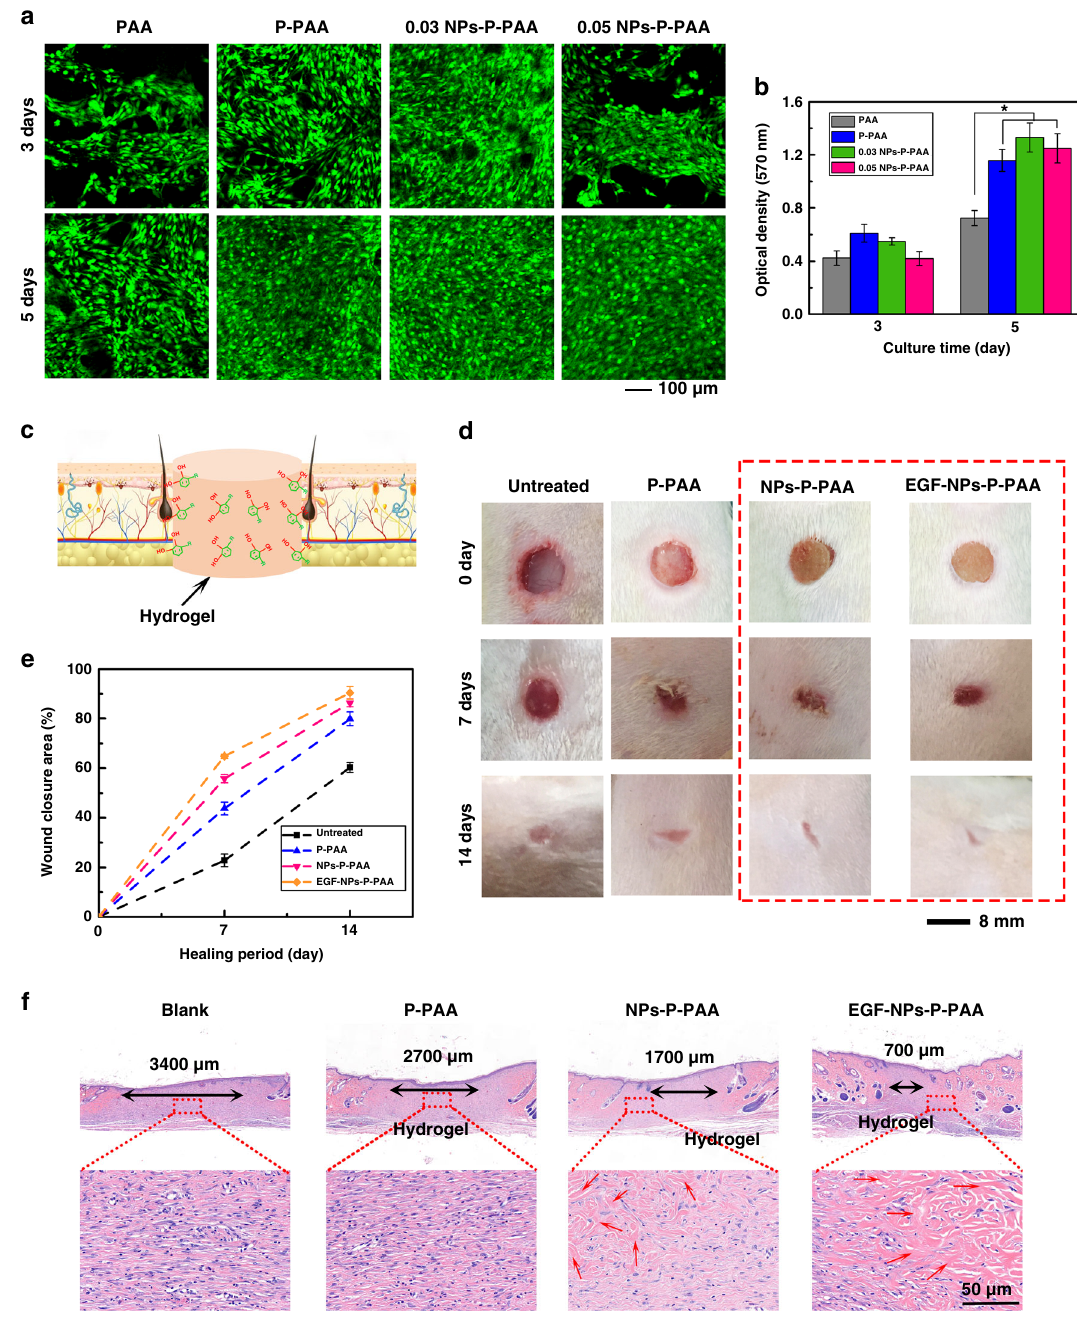
Fig. 5 The biocompatible NPs-P-PAA hydrogel used to repair a full-thickness skin defect. a Confocal laser scanning microscopy (CLSM) micrographs of fi broblasts on various hydrogels. b MTT assay of the proliferation of fi broblasts. (Error bar means the standard deviation, * indicates statistical difference at p < 0.05, p value was generated by one ‐ way analysis of variance (ANOVA), followed by Tukey's multiple ‐ comparison post hoc test, n = 4). c Scheme of the hydrogel implanted into the skin defect of a rat. d Percent wound closure at different periods of post wounding. e Representative of the gross appearance of defects treated with various hydrogels. f Hematoxylin – eosin (H&E) staining of the wound section after 14 days of treatment. NPs, nanoparticles; P, pectin; PAA, polyacrylic